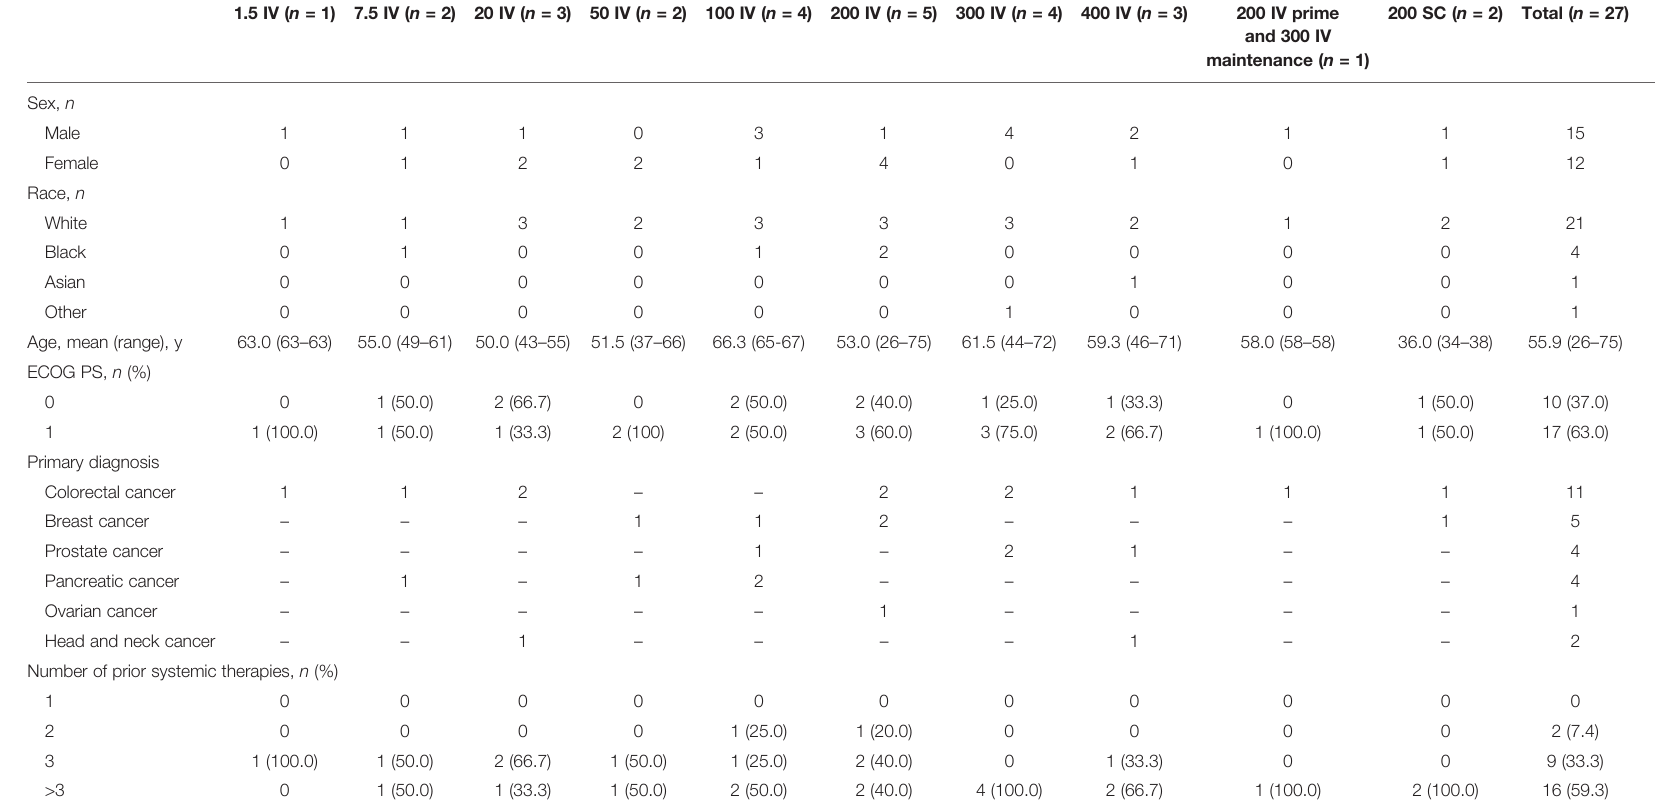
TABLE 1 | Patient demographics and baseline